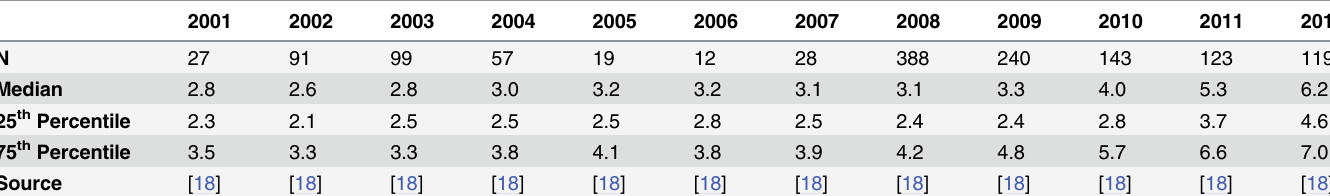
Table 1. Summary of the data from the Thai-Myanmar border stratified by